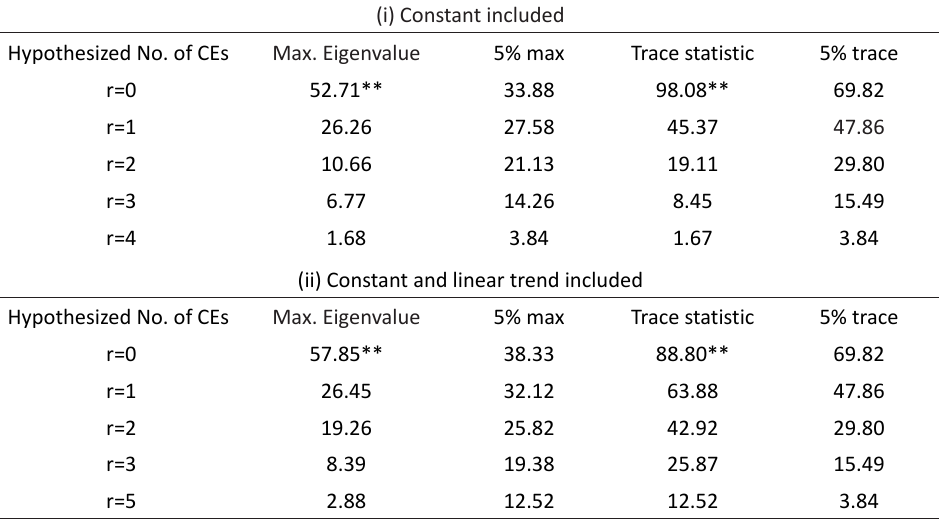
Table 3. Test for cointegration among LogR, LogP, LogDS, LogS and LogM index series (i) Constant included